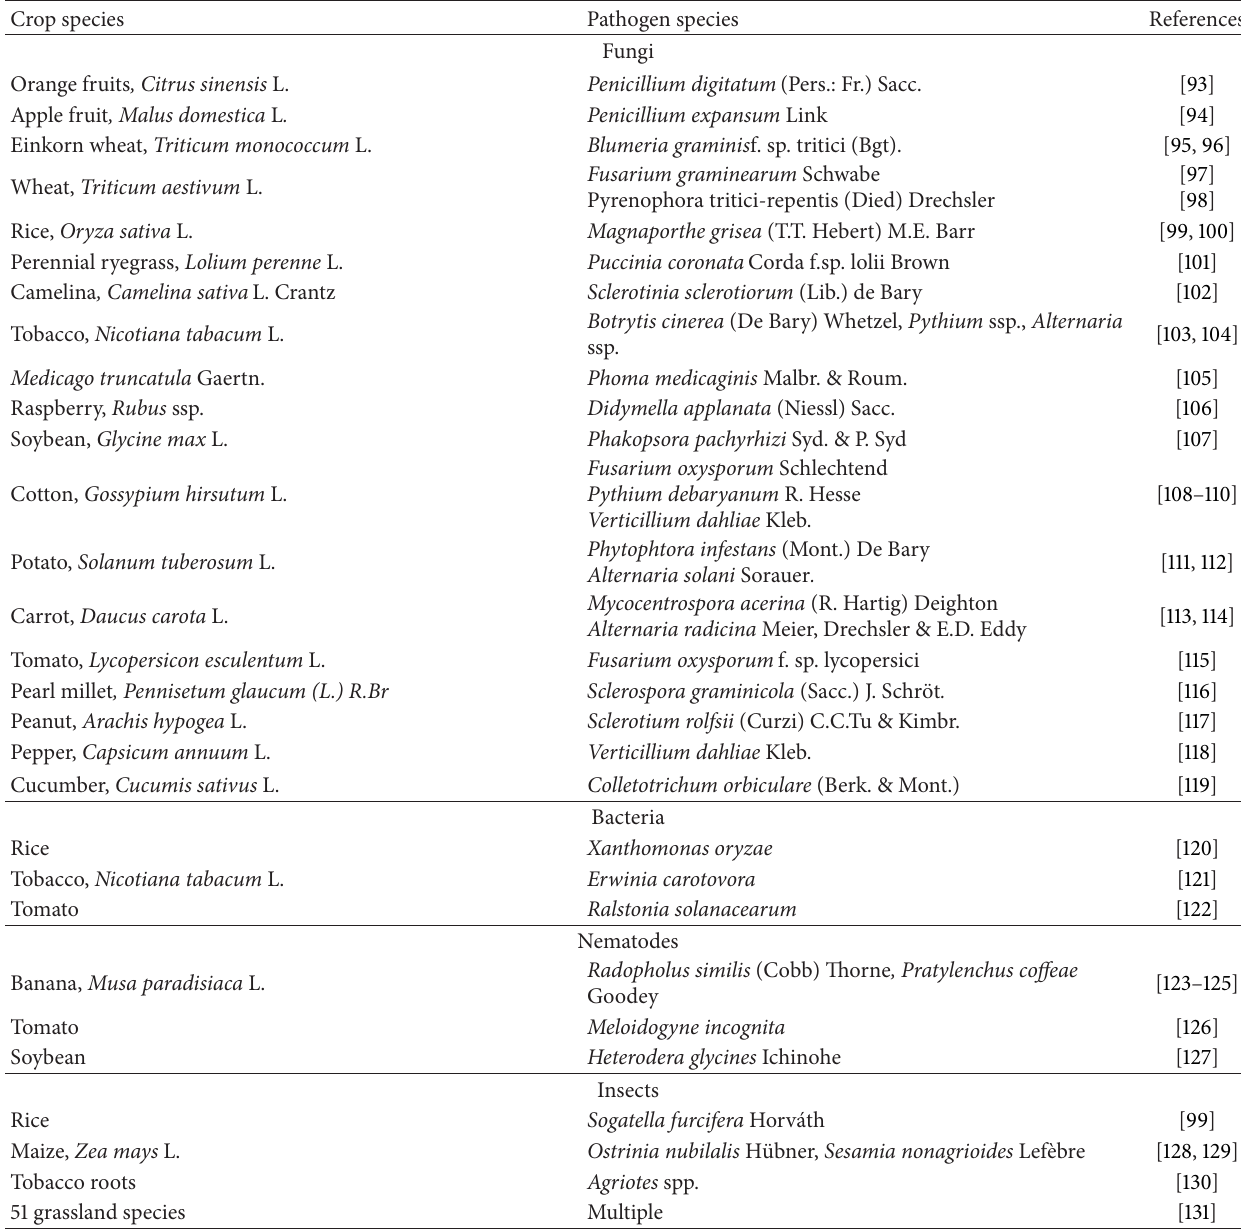
Table 2: Summary of studies suggesting lignification as an effective defense mechanism against biotic stresses in agricultural